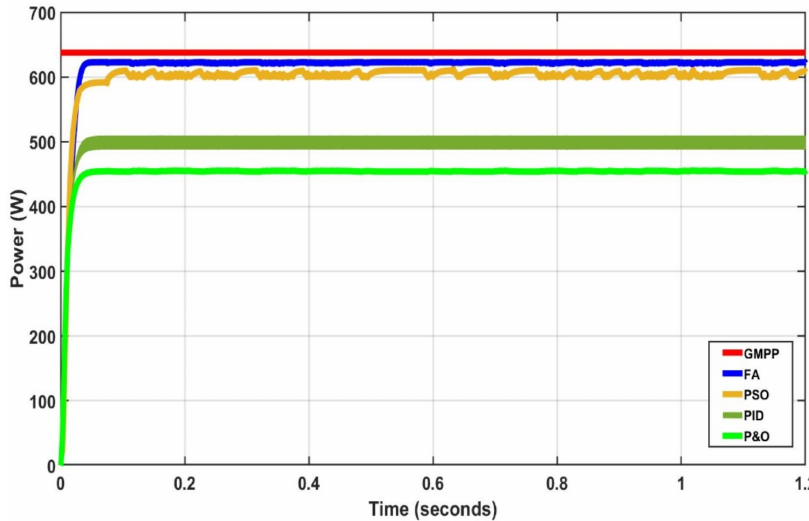
Figure 42. Comparison of FA with PSO, P&O and PID